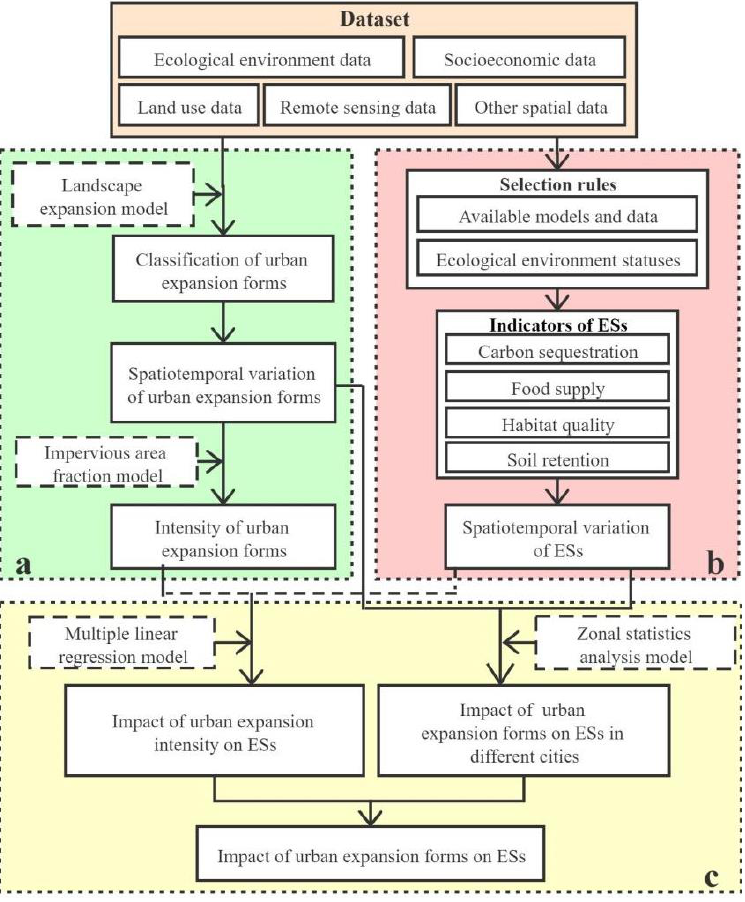
Figure 2. Framework of the research: ( a ) Evaluation of change and intensity of urban expansion forms; ( b ) Evaluation of four ESs that are important in SHB; ( c ) Analysis of impact of urban expansion forms on ESs.